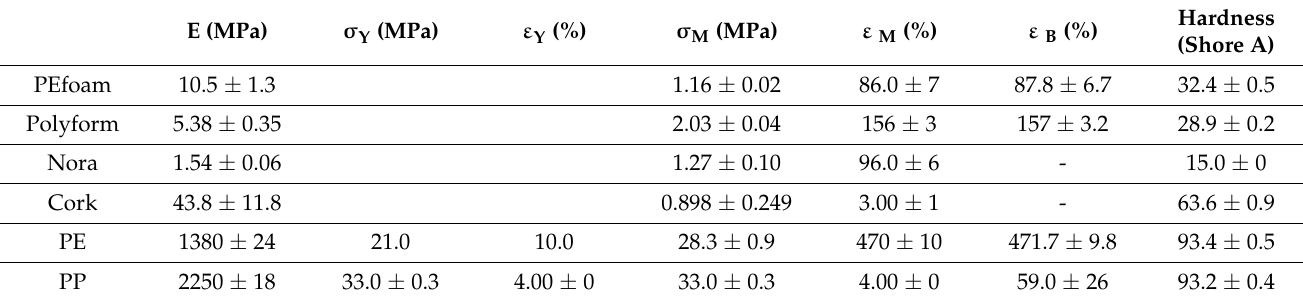
Figure S1a–f. The mean values of five parallel measurements of different selected tensile properties are presented in Table 3. In the case of solid polymers (PE and PP samples; (Figure S1e,f) the yield strength ( σ Y ) and the yield strain ( ε Y ) are close together for all parallels; they are 21 MPa and 10% for PE and 33 MPa and 4.0% for PP sample. But the maximum tensile stress ( σ M ) for the PE sample is achieved only near the break (28.3 MPa; 470%), while for PP sample σ M is actually σ Y (33 MPa). The strain at break ( ε B ) for the PP sample scatters among specimens from 23% to 89%. It can also be deduced from Table 3 and Figure S1a–d that all the remaining four samples have quite similar shapes of tensile measurement curves. The maximum tensile stress ( σ M ), the nominal strain value at maximum tensile stress ( ε M ) and the strain at break ( ε B ) were all near the end of the curves, near the break that occurred. The Young’s modulus of 2250 MPa is the largest for PP, following 1380 MPa for PE. Foamed polymeric materials have lower values of the Young’s modulus: 3.8 MPa for cork, 10.5 MPa for expanded PE, 5.38 MPa for Polyform and Table 3. The mean values with the standard deviations of Young’s modulus (E), the tensile stress at yield ( σ Y ), the tensile strain at yield ( ε Y ), the maximum tensile stress ( σ M ), the nominal strain at maximum tensile stress ( ε M ) and the strain at break ( ε B ), and hardness (Shore A) of 6 selected orthotic and prosthetic materials. Hardness E (MPa) σ Y (MPa) ε Y (%) (Shore